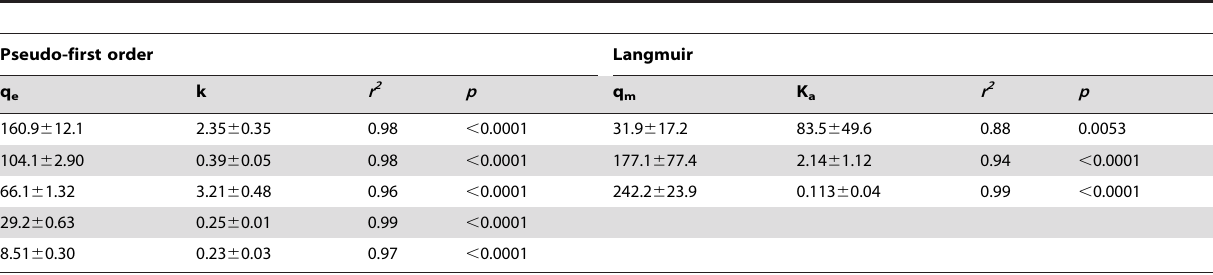
Table 1. Values of the different parameters obtained when simulating the kinetics and equilibrium isotherm of Cd 2 + adsorption by TiO 2 -ENs with the pseudo-first order and Langmuir models, respectively.